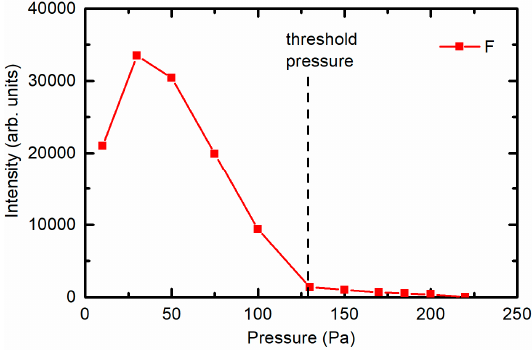
Figure 8. OES intensity of the F emission line at 703 nm versus SF 6 pressure.